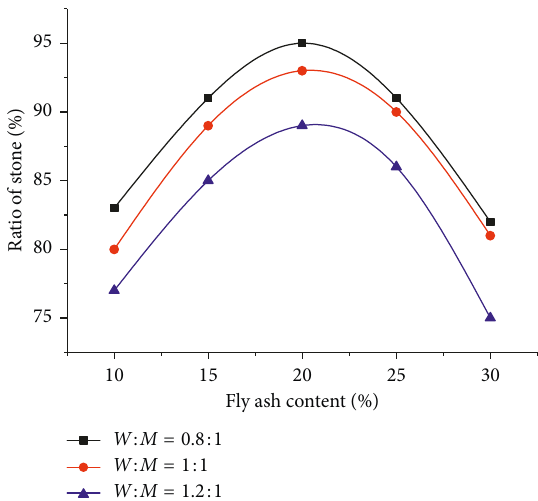
Figure 2: The ratio of stone changes with fly ash content.